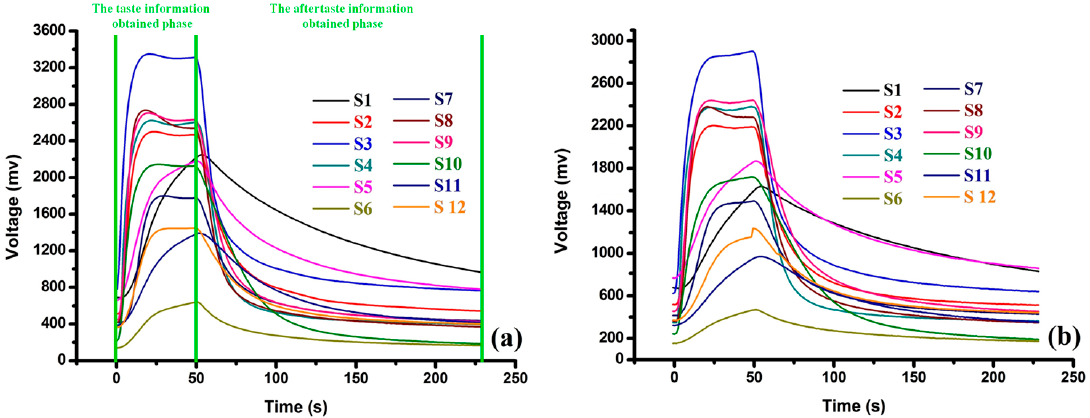
Figure 2. The response signals obtained by the E-nose from the wine samples of 5Y ( a ) and 20Y ( b ).